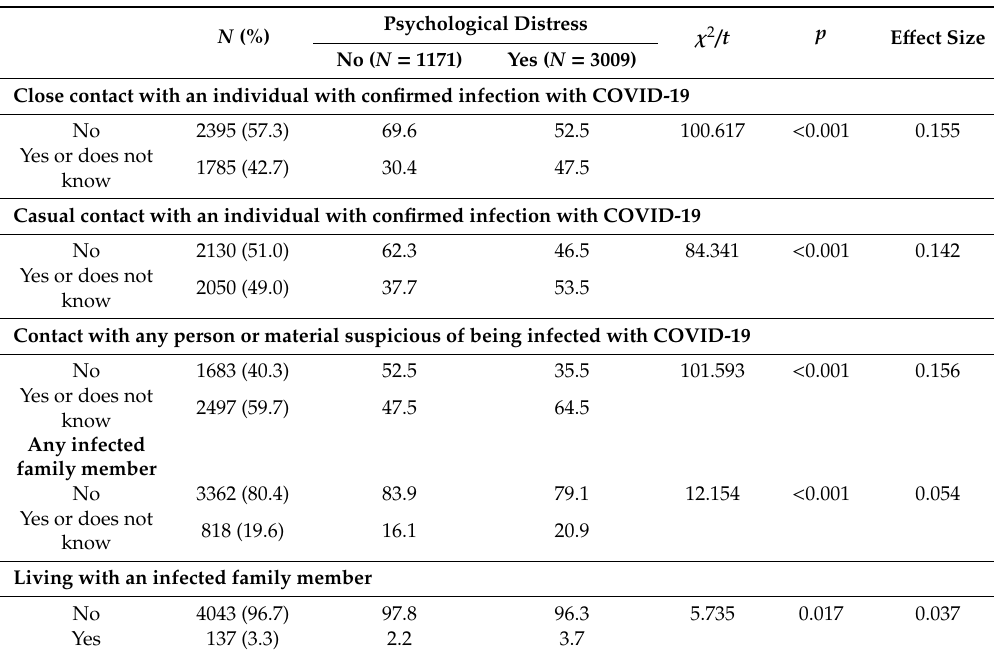
Table 5. Association between contact history variables in the past 14 days and psychological distress during the COVID-19 pandemic (n =